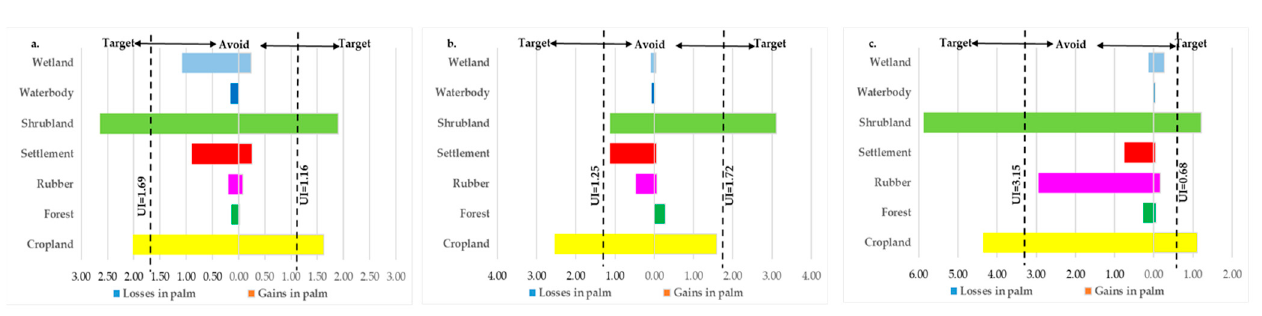
Figure 9. Transition level intensities for cropland for the period ( a ) 1986–2002, ( b ) 2002–2015 and ( c ) 2015–2020 (gains on the right, losses on the left).